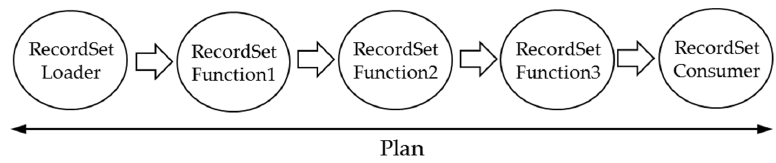
Figure 6. A description of a Plan in Marmot: A chain of RecordSetOperators.